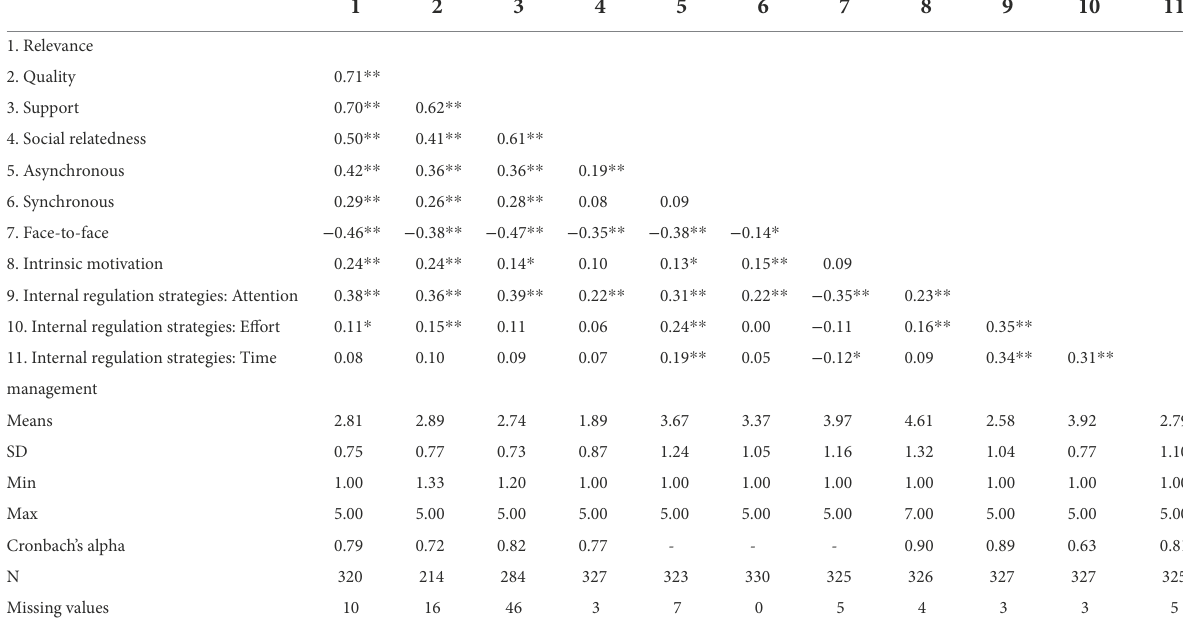
TABLE 1 Descriptive results, correlations, and reliabilities.